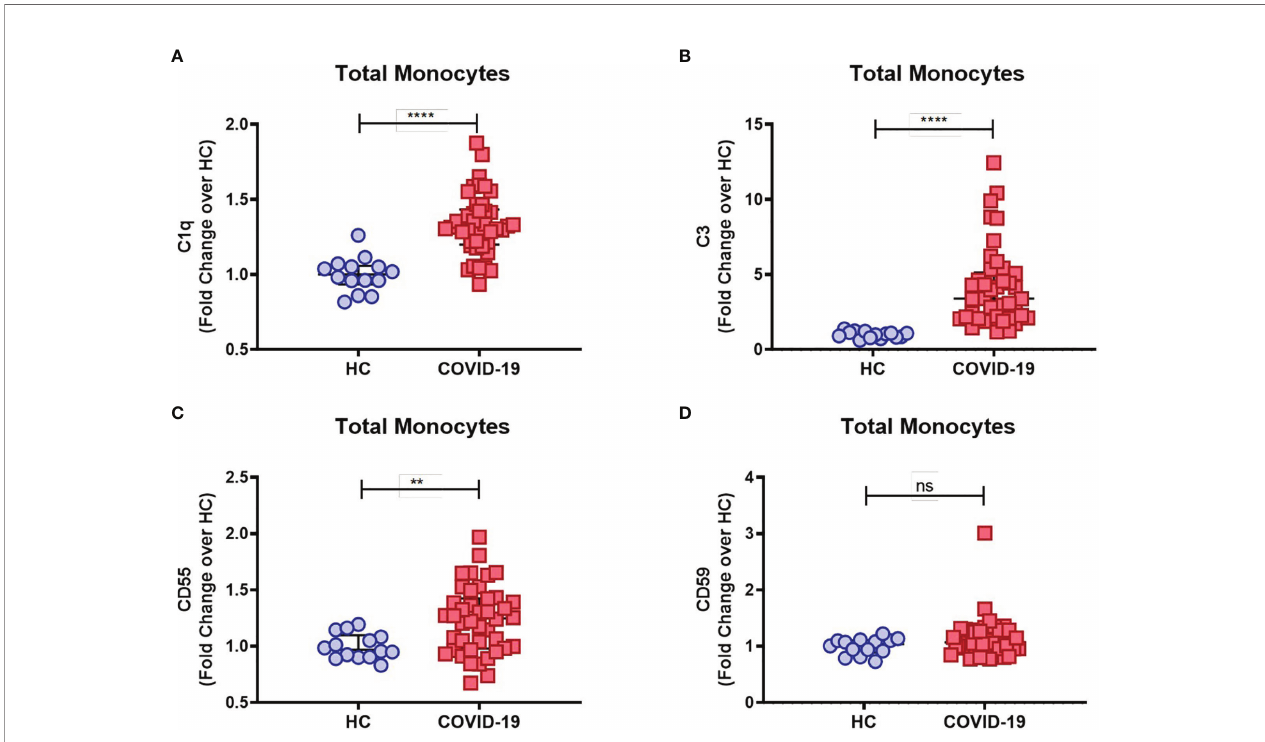
FIGURE 1 | Complement deposition on circulating blood monocytes during acute COVID-19. The mean fl uorescence intensity (MFI) of C1q (A) , C3 (B) , CD55 (C) and CD59 (D) expression on circulating blood monocytes was compared between healthy controls (HC) (n = 14) and COVID-19 patients (n = 42) by fl ow cytometry and presented as Fold change over their respective experimental HC mean, and graphs depict median and interquartile range. Data were analyzed using the Mann- Whitney test. ****P < 0.0001; **P < 0.01; ns , not signi fi